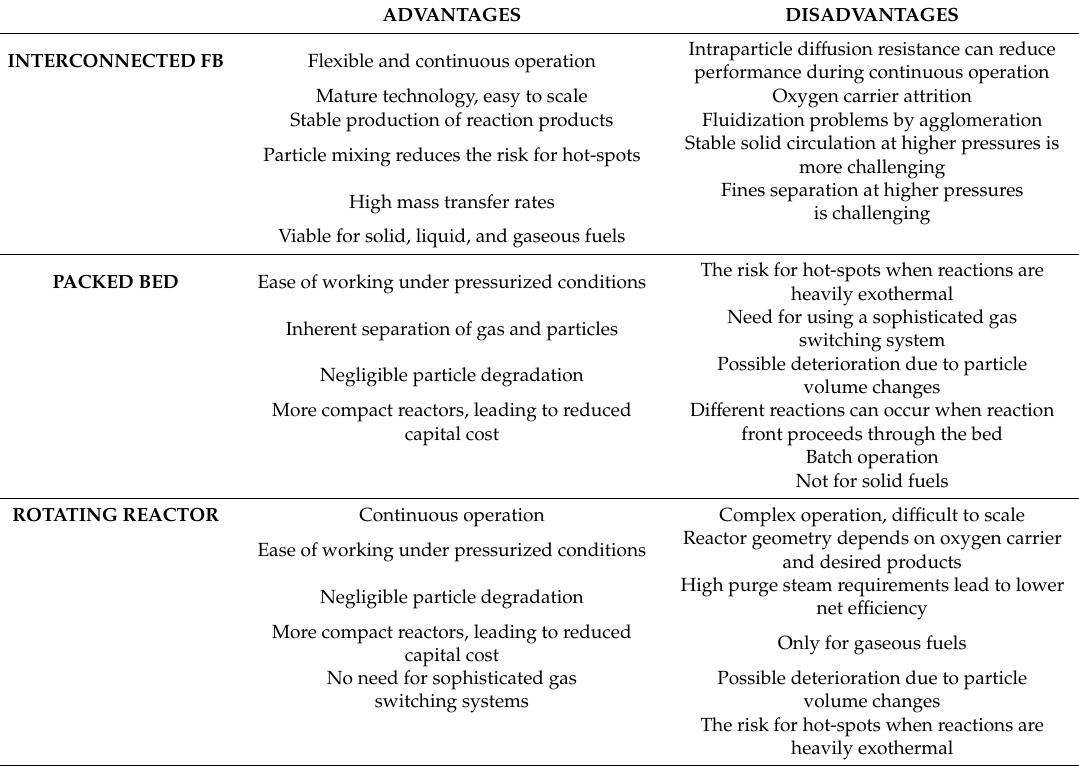
Table 3. Advantages and disadvantages of several investigated reactor concepts related to chemical